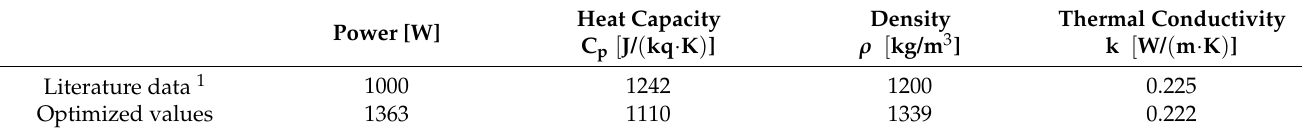
Table 1. Comparison between the important parameters before and after the optimization Figure 7. The chart flow of the optimization algorithm.